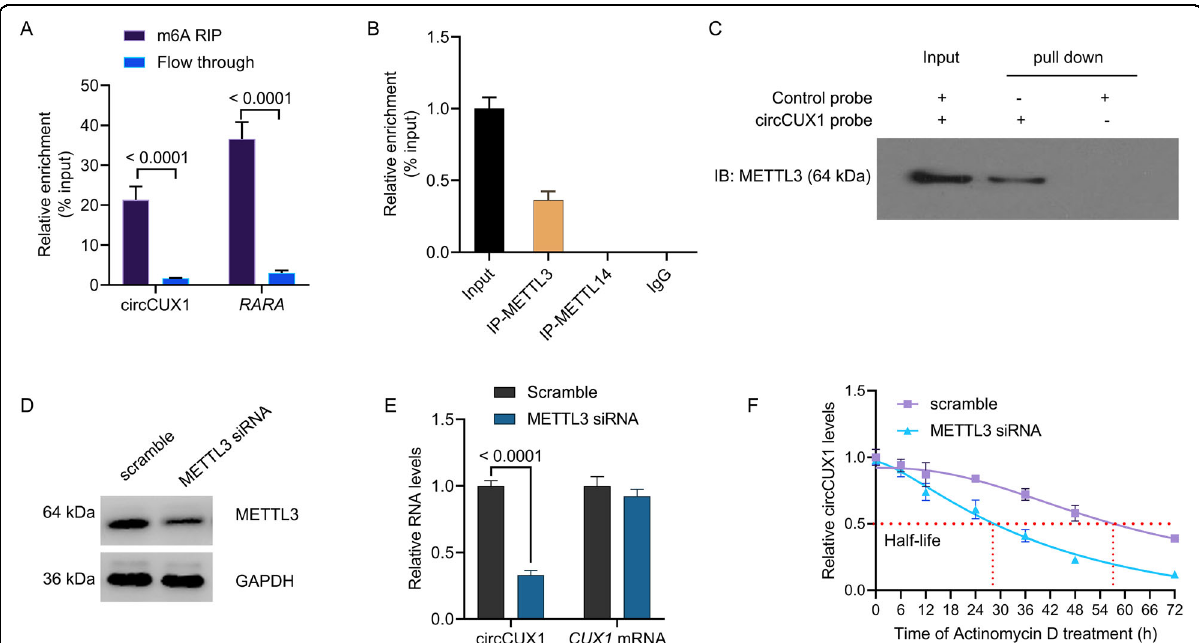
Fig. 4 METTL3 promotes m6A-methylated circCUX1. A RIP assay showing that circCUX1 was highly recruited in m6A precipitated fraction in Fadu cells. B RIP assays showing the association of METTL3 and METTL14 with circCUX1 in Fadu cells. Relative enrichment representing RNA levels associated with METTL3 and METTL14 relative to an input control. IgG antibody served as a control. C The circCUX1-protein complex pulled down by circCUX1 junction probe with protein extracts from Fadu cells. Immunoblot analysis of METTL3 after pull-down assay showing its speci fi c association with circCUX1. D Western blot analysis for the expression of METTL3 after METTL3 siRNA transfection in Fadu cells. E qRT-PCR analysis for the expression of circCUX1 and CUX1 mRNA after METTL3 siRNA transfection in Fadu cells. F qRT-PCR analysis for the expression of circCUX1 after treatment with Actinomycin D at the indicated time points in Fadu